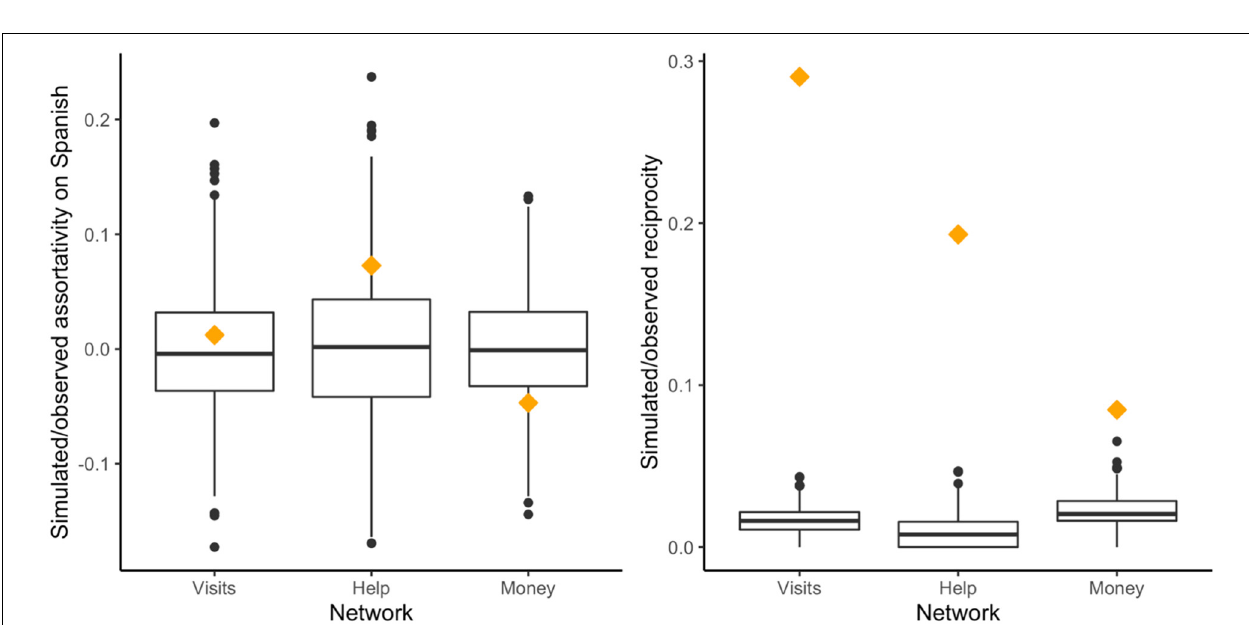
FIGURE 5 | On the (left) , assortativity on whether individuals speak Spanish or not for the three social networks is shown. On the (right) , reciprocity for the three social networks is shown. Orange diamonds show observed assortativity coefficients (left) and reciprocity coefficients (right) . Boxplots represent null distributions generated from a permutation test of 1,000 random networks with the same numbers of nodes, edges, and Spanish speakers like in the observed networks. The boxes represent the interquartile range (IQR); the line through the middle is the median. Whiskers extend to 1.5 × IQR; outliers are plotted as dots.